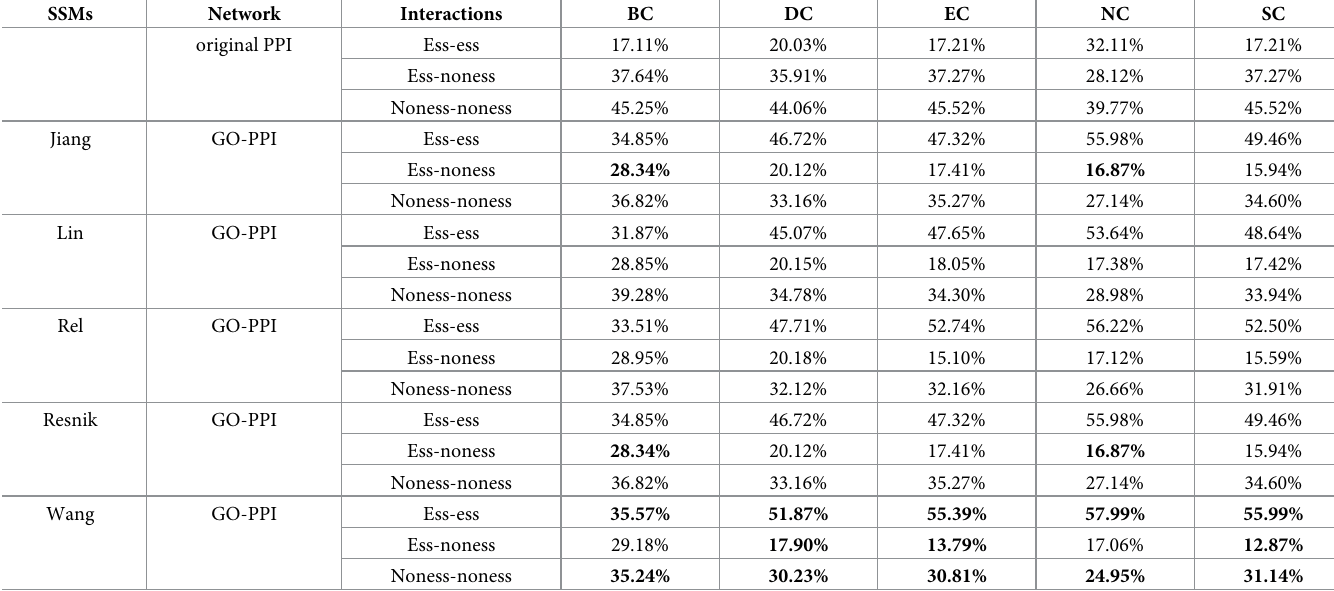
Table 3. The portions of interactions under the original PPI network and GO-PPI network for the YDIP dataset (BP).